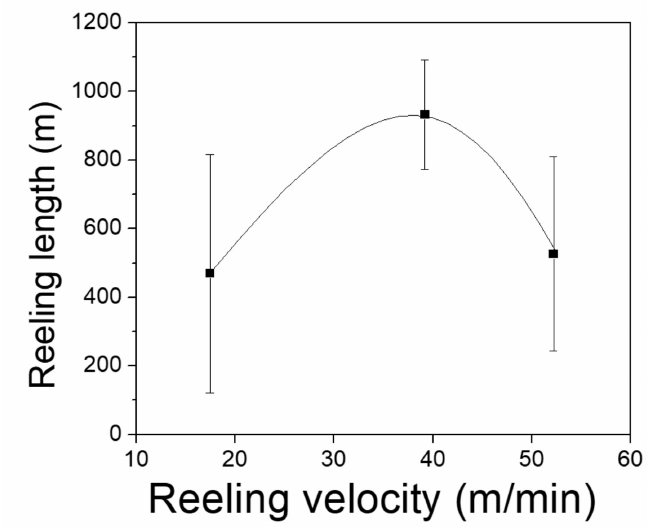
Figure 5. Effect of reeling velocity on the reel-ability of silk filament from silk cocoons ( n = 20). Reeling bath temperature was 50 ◦